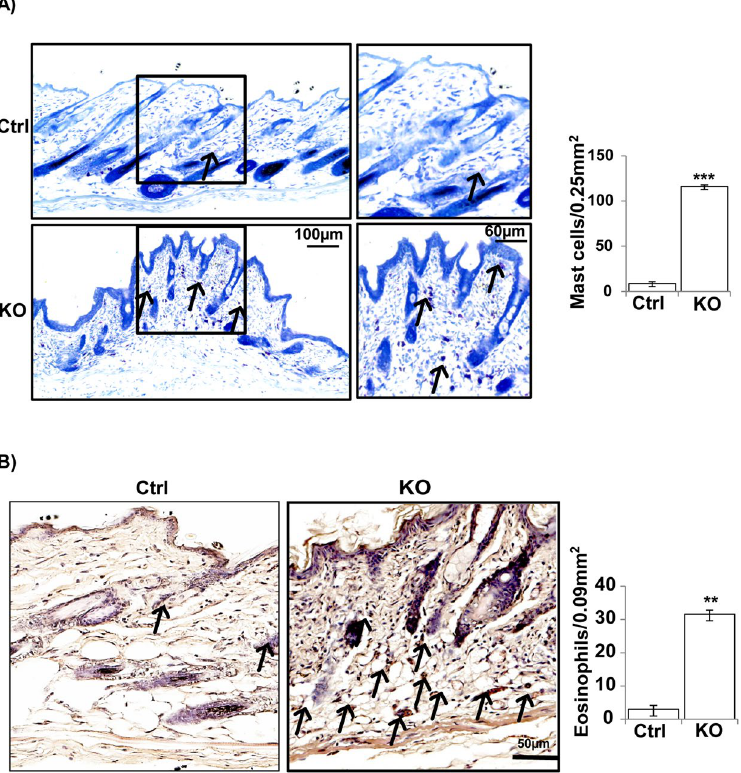
Figure 6. Increased mast cells and eosinophil cells in the skin of N-WASP K14KO mice. (A) Toluidine blue staining showed significant increased infiltration of mast cells in dermis of skin in N-WASP K14KO mice compared to control mice on 23 rd day. (B) Congo red staining showed significant increased infiltration of eosinophils in the dermal layer of N-WASP K14KO mice compared to control mice on 23 rd day (n = 3). ( ↑ ) indicates mast cells and eosinophils. Results are mean ± SEM *** p < 0.001, ** p < 0.01. (n =